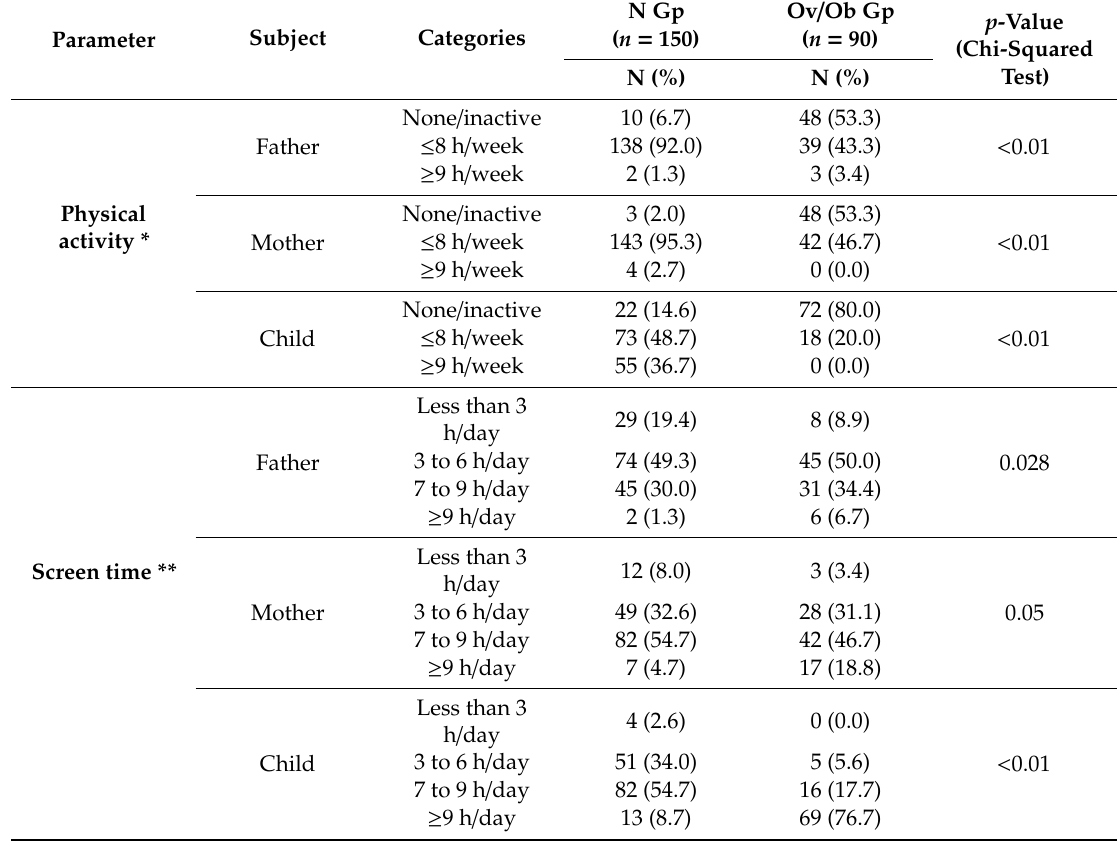
Table 3. Comparative di ff erences in physical activity and screen time for parents and child between the two groups and their respective